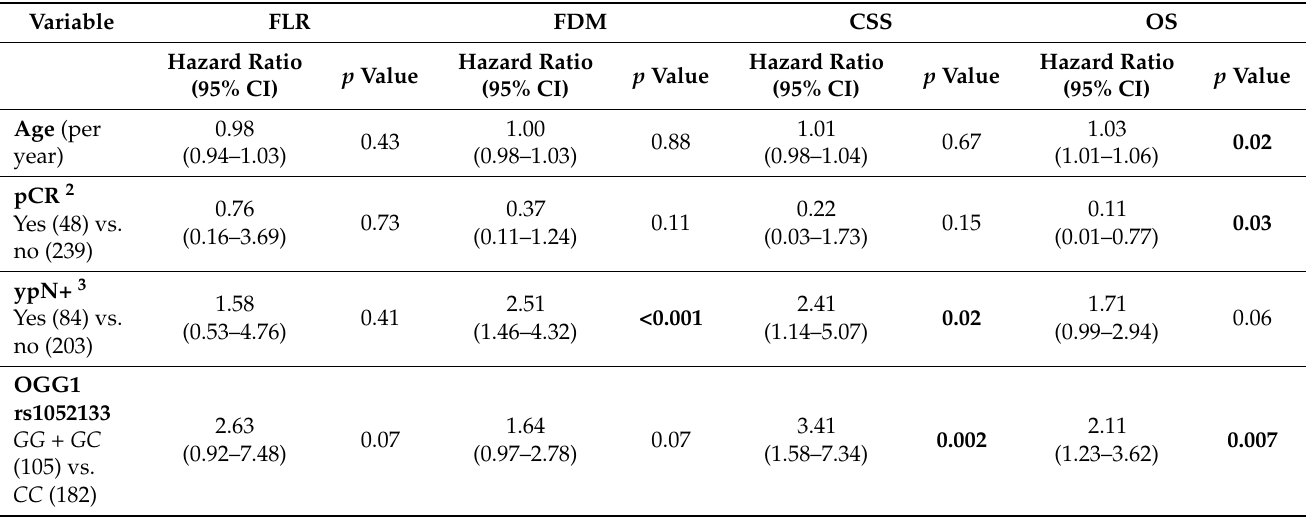
Table 4. Multivariable Cox regression with the same outcome parameters as in Table 3. Variables that had a p < 0.05 with any of the outcome measures in the univariable analysis were put in the models (in bold). 2 pCR = pathological complete